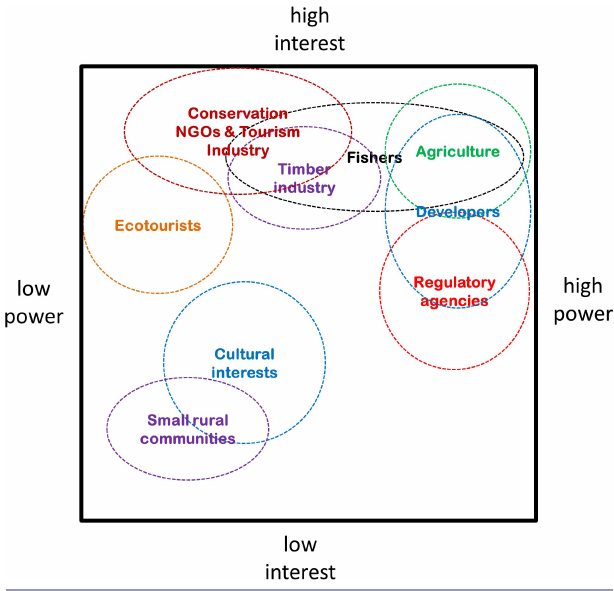
Fig. 3 . Major stakeholder groups and their perceived level of interest and power as identified by the Cape Romain Partnership for Coastal